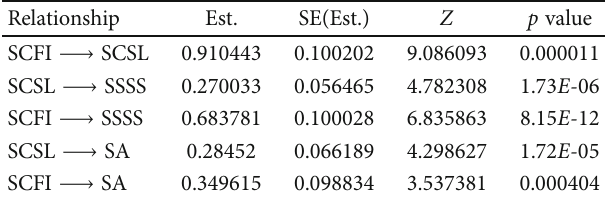
Table 5: Parameter estimates based on the maximum likelihood